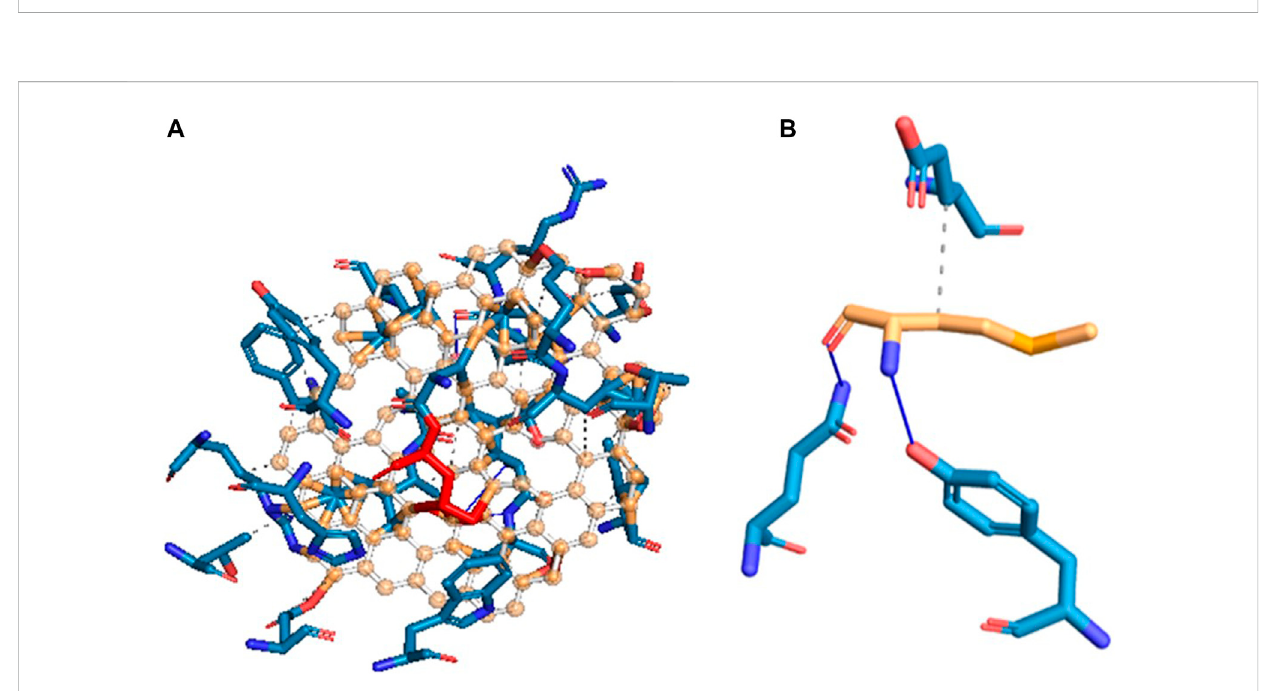
FIGURE 10 Hydrogen bond and hydrophobic interactions of (A) pelB protein and (B)